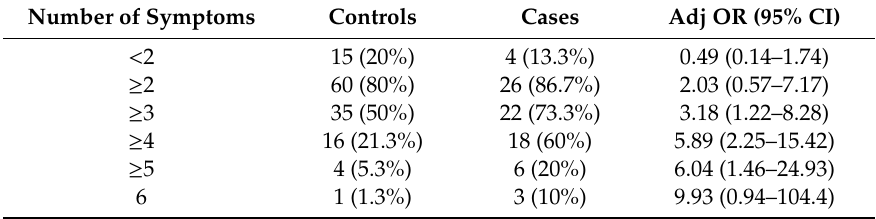
Table 4. SARS-CoV-2 test results by number of symptoms reported at the time of